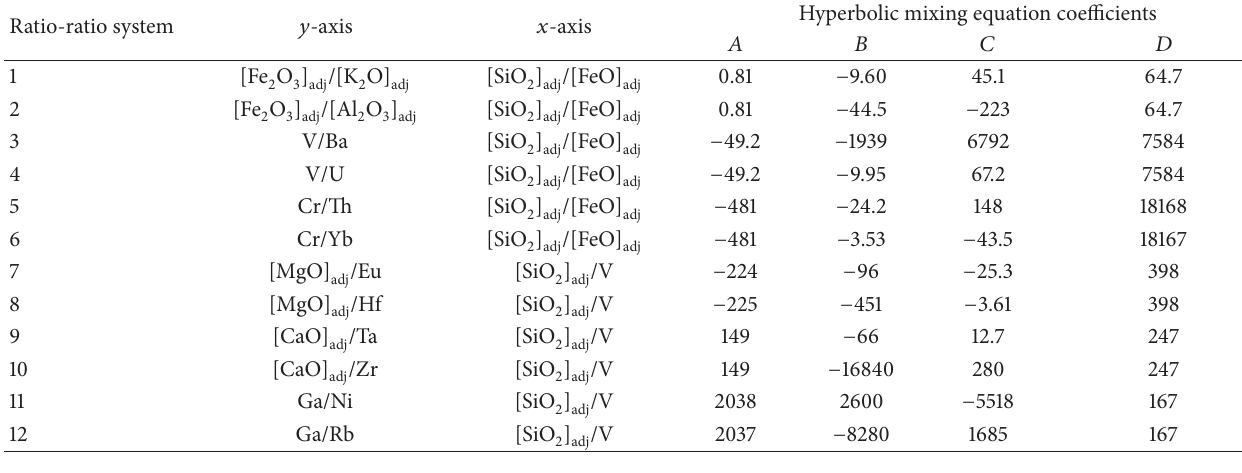
Table 7: 𝐴 – 𝐷 coefficients of hyperbolic Equations (10a)–(10d) for magma mixing between N1 and N3 end-members (northern Sierra de las Cruces sector), generated applying the mass-balance model by Zou [33].